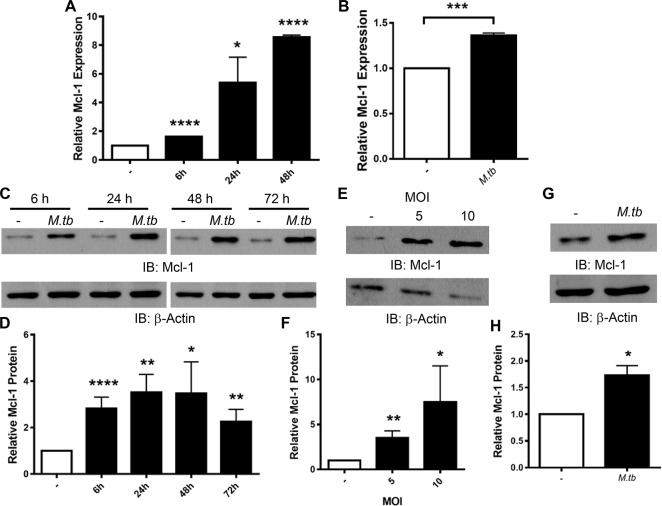
M.tb induces Mcl-1 expression in human macrophages.MDMs (A, C-F) and HAMs (B, G, H) were infected with M.tb at MOI 5 for the indicated times (A, C, D), at the indicated MOI for 24 h (E and F), or at MOI 5 for 24 h (B, G, H). A and B) Total RNA was collected and gene expression of Mcl-1 analyzed by qRT-PCR. Results are expressed as Mcl-1 expression relative to uninfected cells and are the mean ± SEM of N = 2–3. C-H) Protein lysates were collected and analyzed by Western blot (C, E, G). Densitometry analysis of Western blots was conducted with Image J (D, F, H). Data are expressed as amount of Mcl-1 protein relative to uninfected macrophages and are the mean ± SEM of at least 3 experiments. A-H) * p < 0.05, ** p < 0.01,*** p < 0.001, **** p < 0.0001.